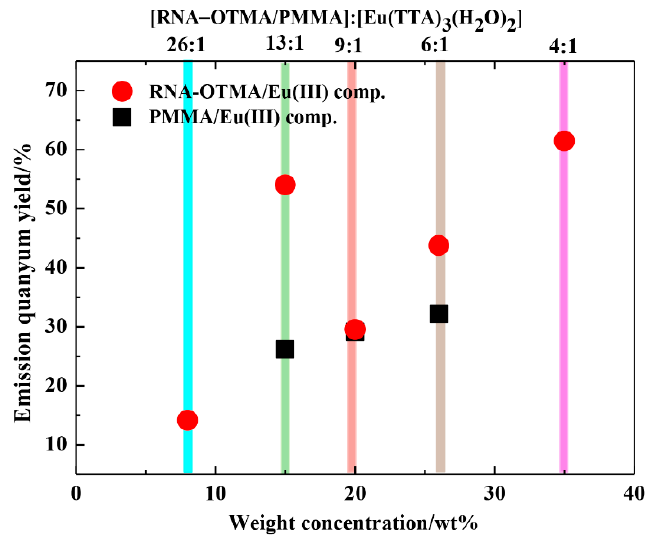
Figure 11. Fluorescence quantum yields of RNA–OTMA/Eu (TTA) 3 (H 2 O) 2 films and PMMA/Eu (TTA) 3 (H 2 O) 2 films.